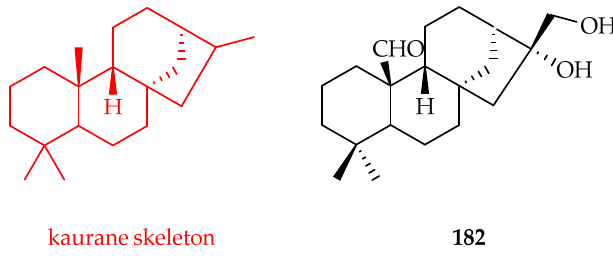
Figure 74. Structures of kaurane skeleton and fischericin D 182 [119].